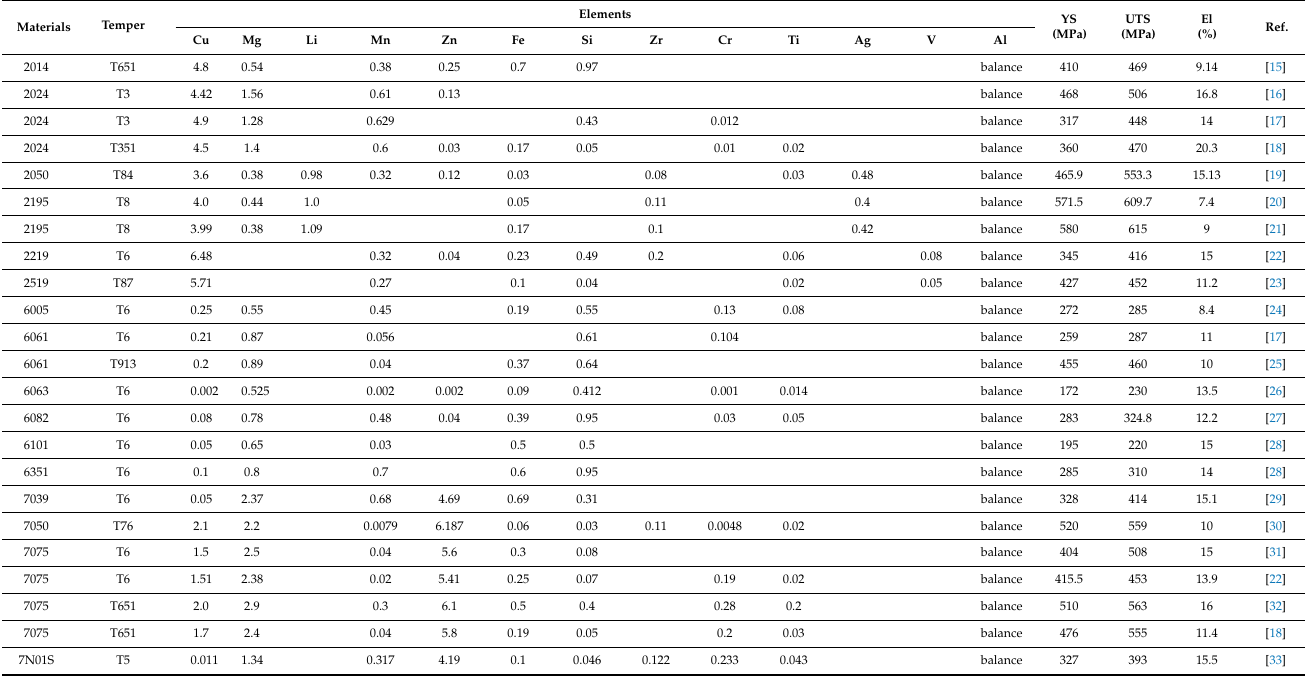
Figure 3. The temperature range of different strengthening phases precipitated (according to [34–36]). The age-hardening aluminum alloy in the peak-aged state has high strength owing to a large number of precipitates that are very fine and coherent, and contributes to the effective resistance to dislocation movement and can cause an intense strengthening effect [13,14]. However, when the coherent, metastable precipitates gradually convert to the semi-coherent metastable phase or non-coherent equilibrium phases and are coarsened quickly, the strengthening effect dramatically declined, and the age-hardening aluminum alloy is then in an over-aged state [7]. Table 4. Summary of the mechanical properties of age-hardening aluminum alloys (yield strength (YS), ultimate tensile strength (UTS), elongation